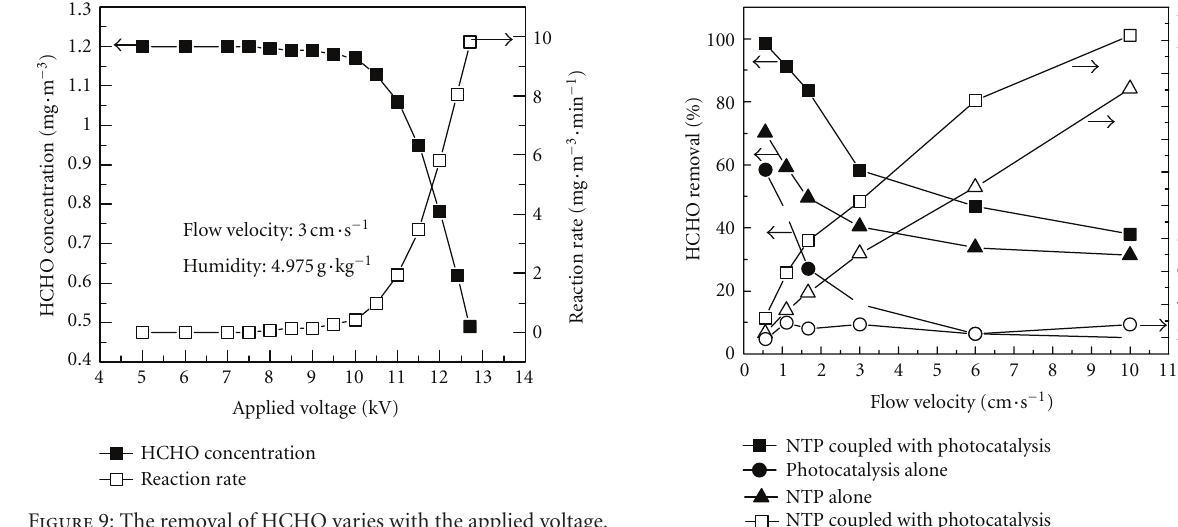
Figure 9: The removal of HCHO varies with the applied voltage.